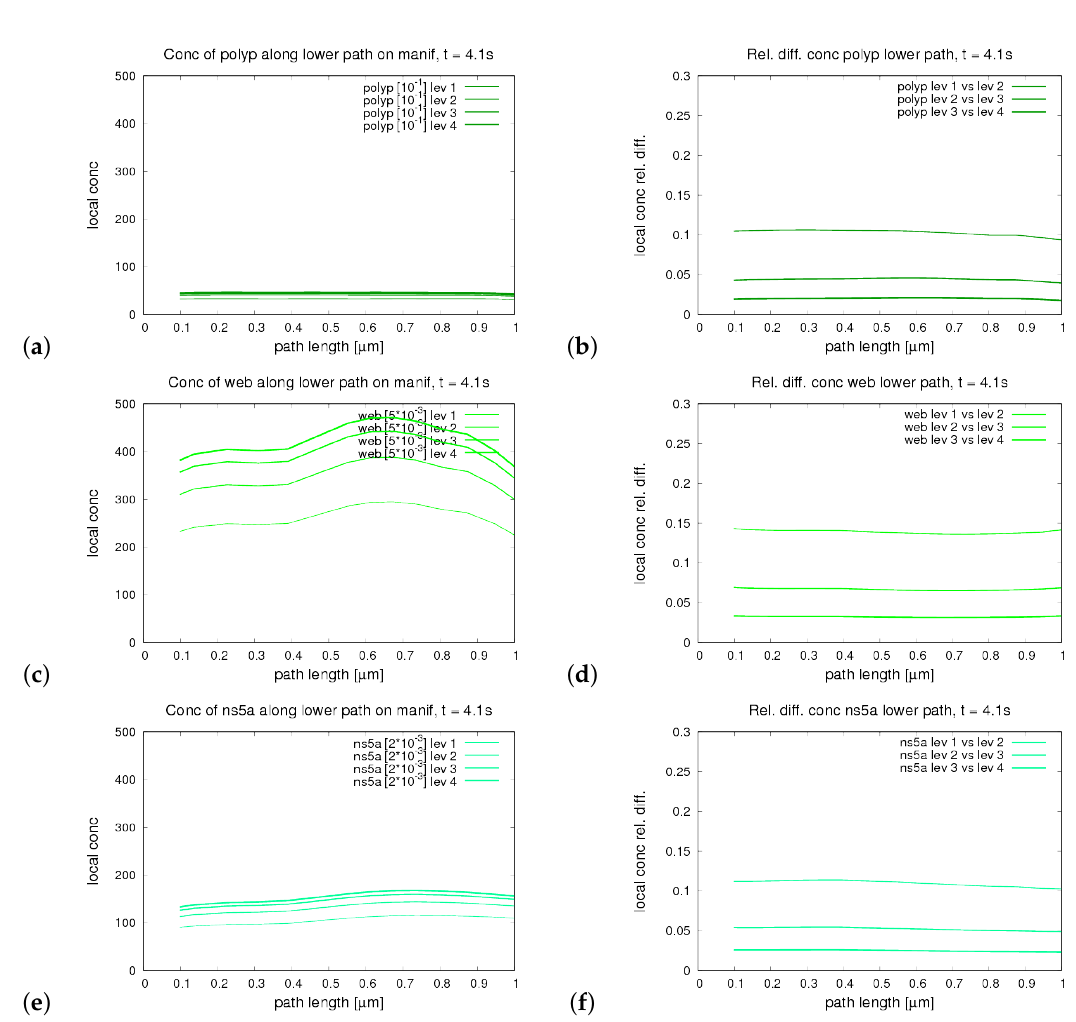
Figure A5. Variation of spatial refinement level for the 1D profiles of the concentrations around a web region. Lower sub path part two. Concentrations of viral protein components. ( a ) Polyprotein absolute values, ( b ) polyprotein relative differences, ( c ) web protein absolute values, ( d ) web protein relative differences, ( e ) NS5a absolute values, ( f ) NS5a relative